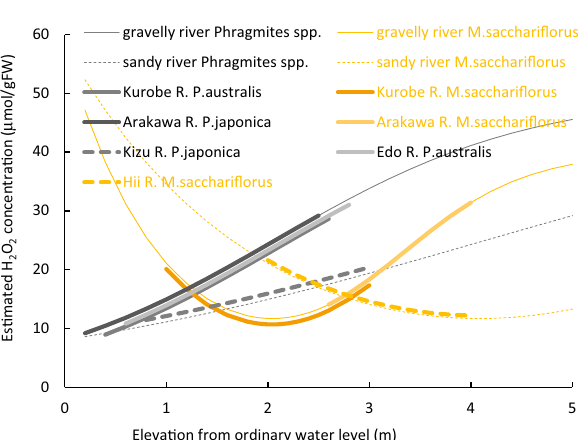
Figure 7. Estimated H 2 O 2 concentration of herb species as a function of elevation from ordinary water level, compared with observed distribution (solid lines: gravelly reaches; dashed lines: sandy reaches; thick lines: observed distribution; gray lines: Phragmites spp.; orange lines: M.sacchariflorus ; Arakawa R., Hii R., Watarase R., Edo R.: this study; Karas R. 51 ; Kurobe R. 27,67